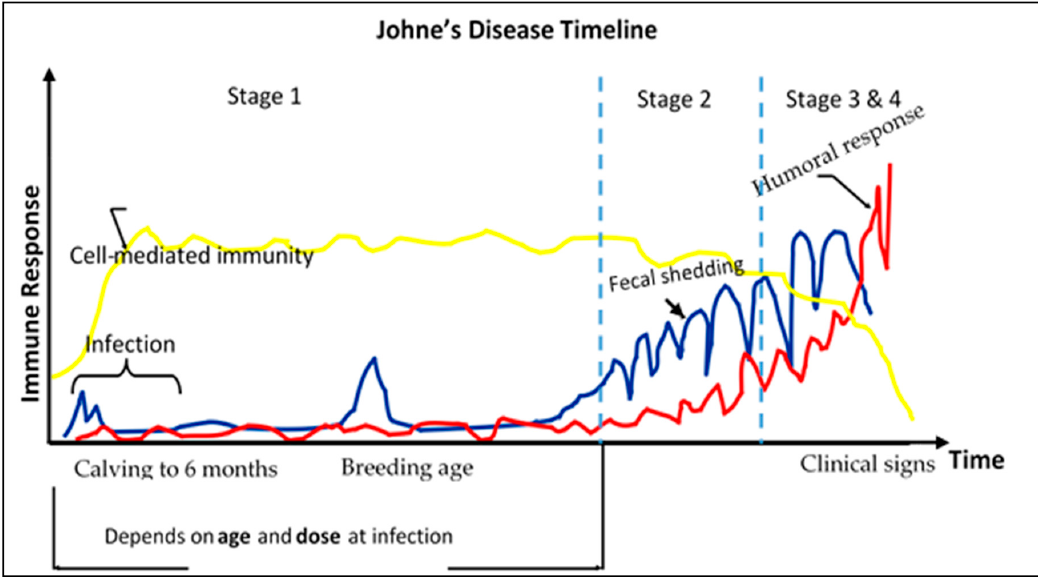
Figure 1. Stage by stage protracted timeline of a bovine infected with Johne’s disease. Source: Adapted Figure1. StagebystageprotractedtimelineofabovineinfectedwithJohne’sdisease. Source: Adaptedfrom from Chiodini et al. [9]. Chiodini et al.